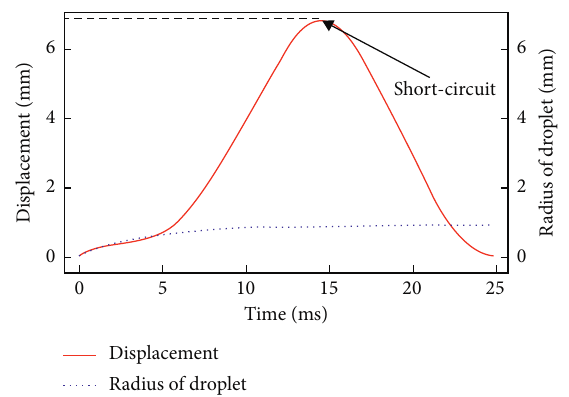
Figure 8: Motion of metal droplet in CMT (wire feed speed is 5.0m/min).